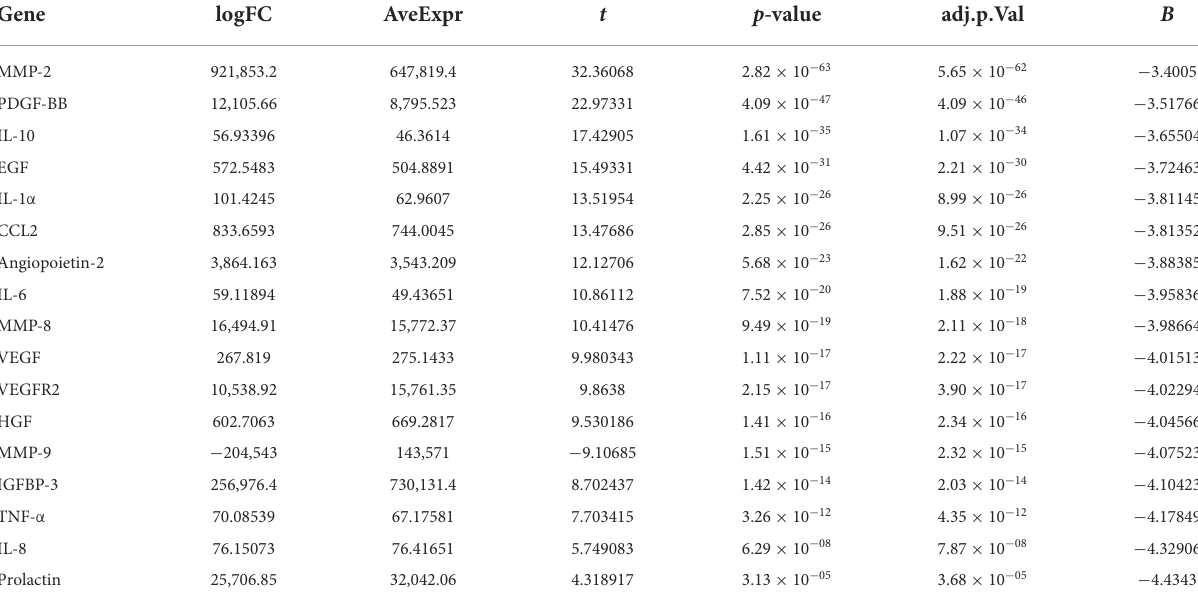
TABLE 2 Differential expression of all cytokines in peripheral blood samples between the preoperative CSDH and normal groups. Gene logFC AveExpr t p -value adj.p.Val B MMP-2 921,853.2 PDGF-BB